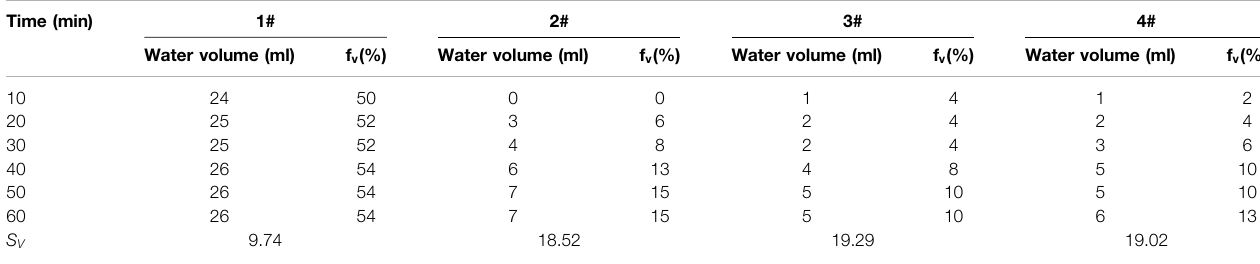
TABLE 5 | Experimental results of stability performance of heavy oil